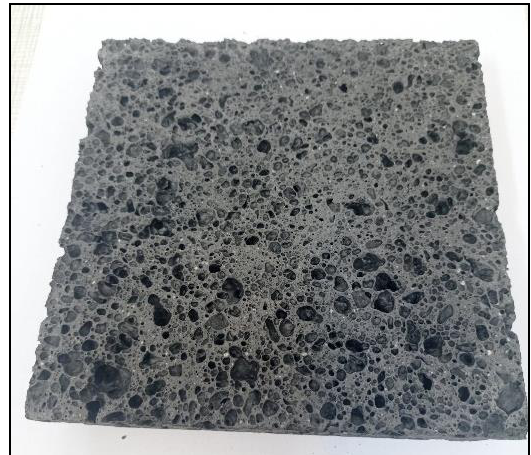
Figure 4. Reference sample from H 2 O 2 .